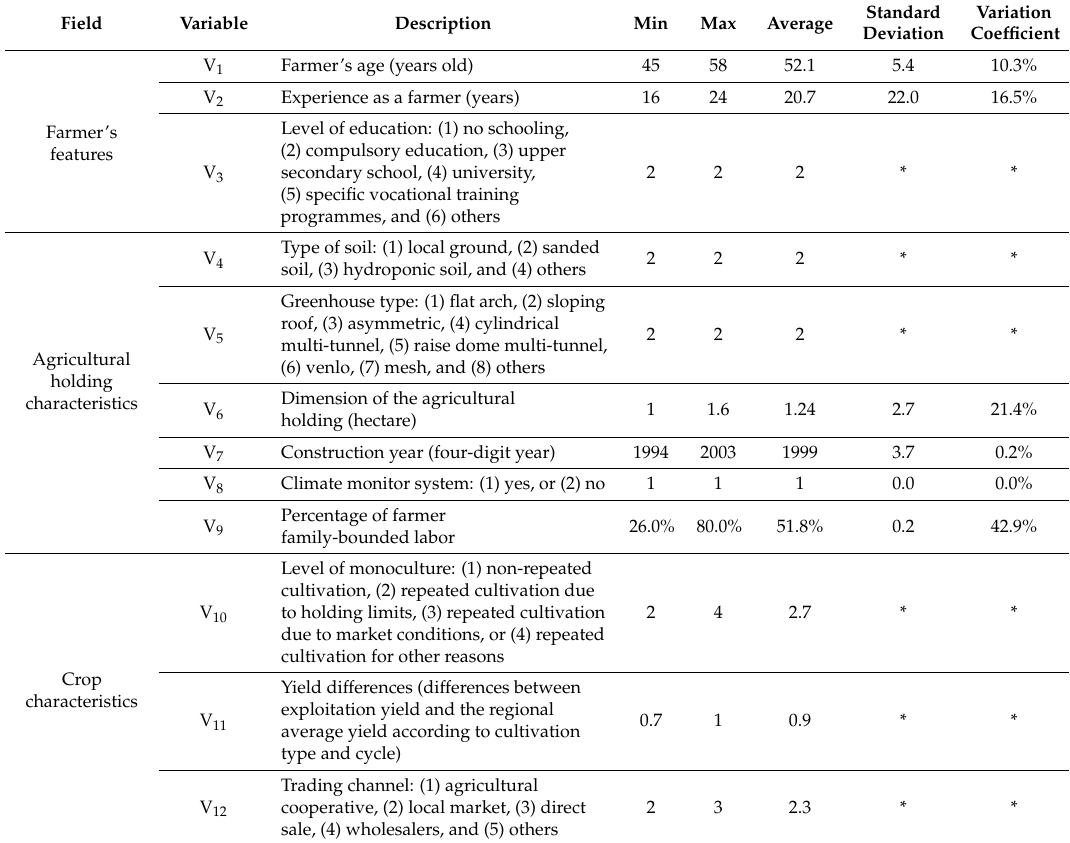
Table 2. Variables and descriptive statistic